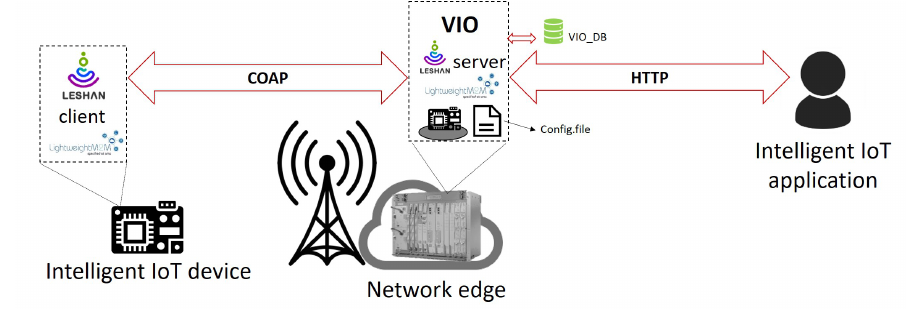
Figure 3. PoC set-up.